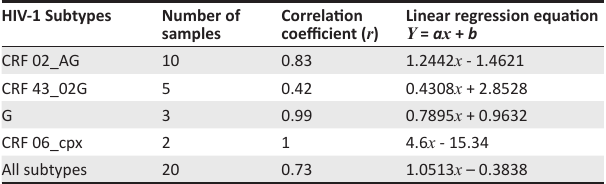
TABLE 1: Correlation coefficient between assays for HIV-1